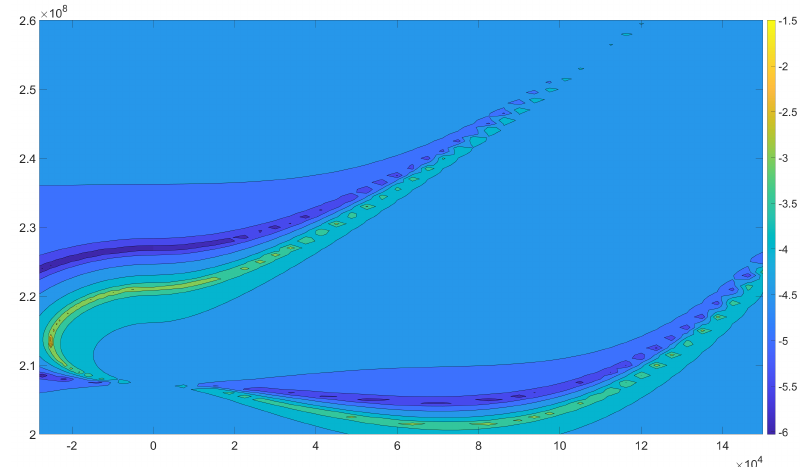
Figure 19. Dispersion curve for imaginary wave numbers (evanescent waves) and for real wave numbers (propagating waves).